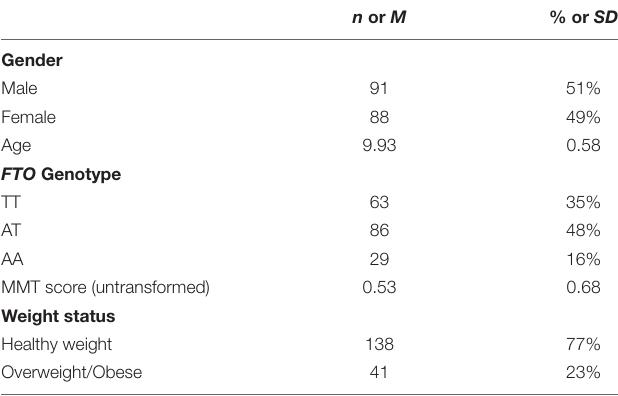
TABLE 1 | Participant characteristics of sample used in all reported